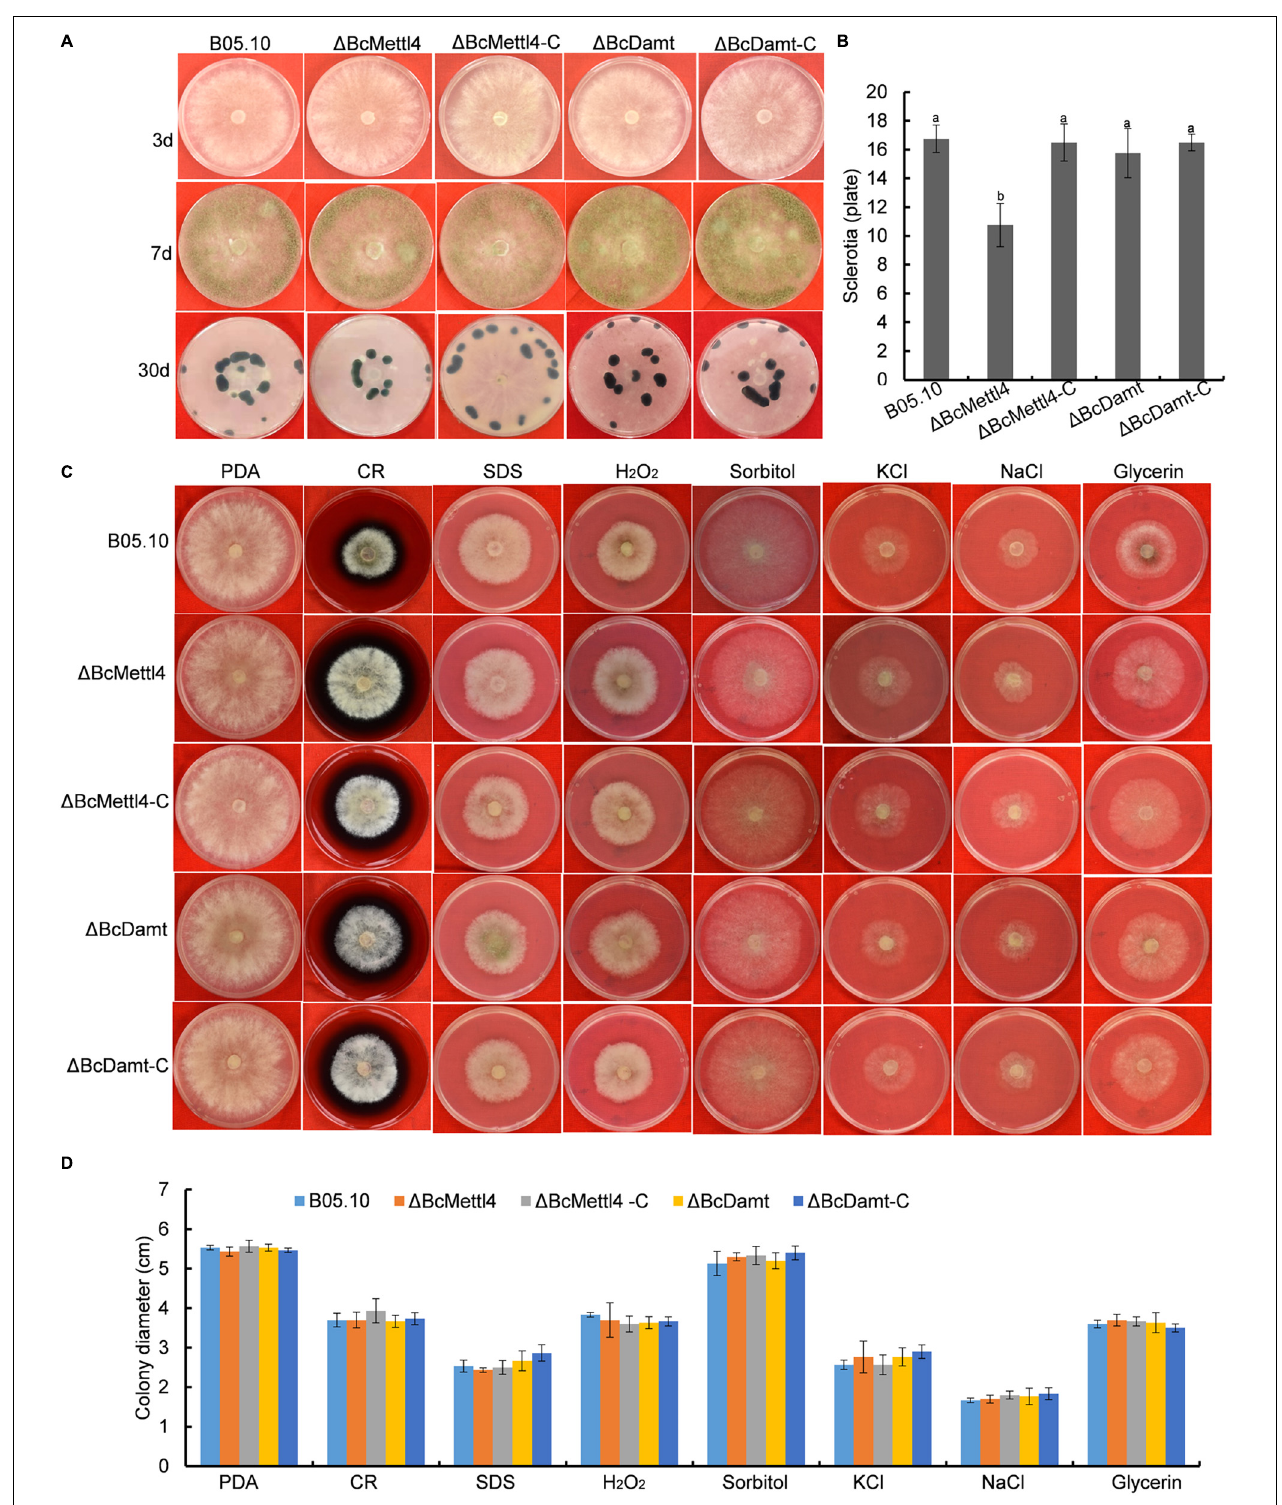
FIGURE 4 | Mycelial growth, conidial and sclerotial formation and stress tolerance of the indicated strains. (A) Mycelial growth, conidial and sclerotial development of various strains grown on PDA plates. (B) Number of sclerotia produced by various strains grown on PDA plates for 30 days in darkness. Bars denote standard errors from three plates. Tukey’s test was employed to calculate significance. The same letters indicated on the bars mean no significant difference in values at p < 0.05. (C) The sensitivity of various strains on stress tolerance. (D) Colony diameter of the indicated strains grown on various stress conditions. Bars represent standard errors from three